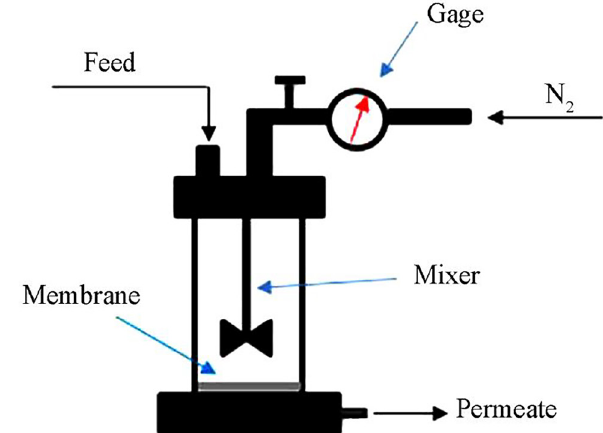
Figure 1: Schematic diagram of the filtration system.